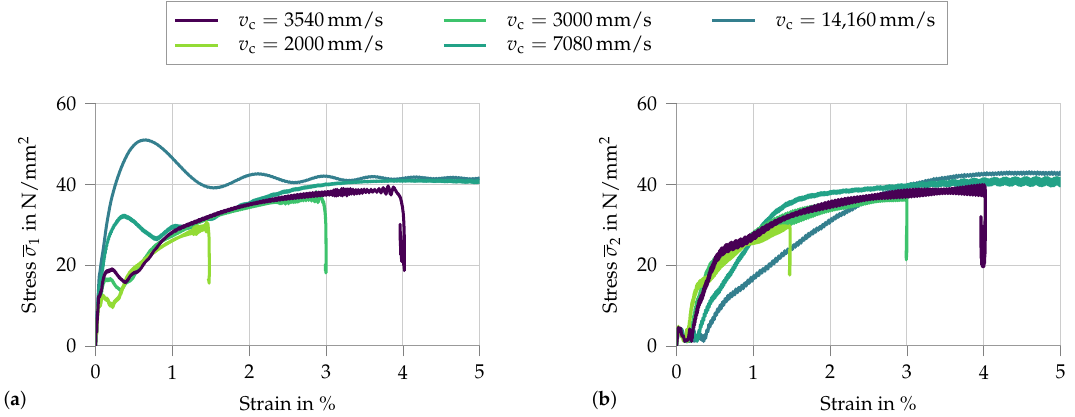
Figure 13. Analysis of the variation of v c from 2000 to 14,160 mm/s, with t cv = 6 × 10 − 5 s: ( a ) the signal σ 1 at the input face; and ( b ) the respective signal σ 2 at the output face.